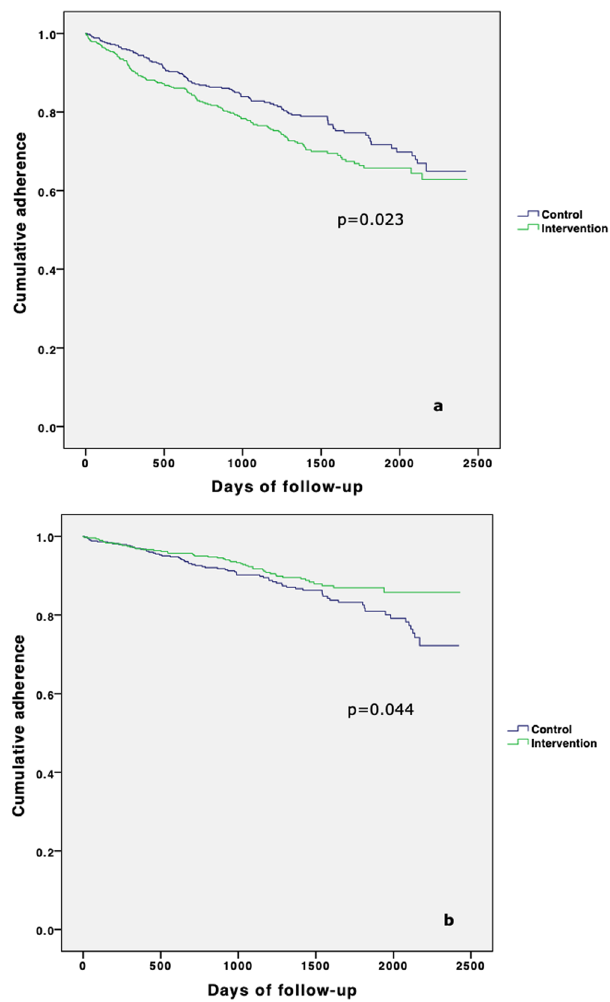
Figure 5. Kaplan-Meier plots on first ( a ) and permanent ( b ) discontinuation.